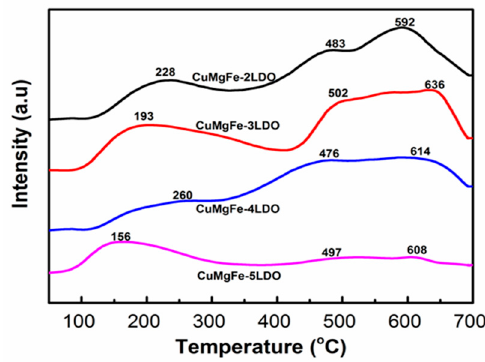
Figure 7. H 2 -TPD profiles of the CuMgFe-xLDO catalysts.